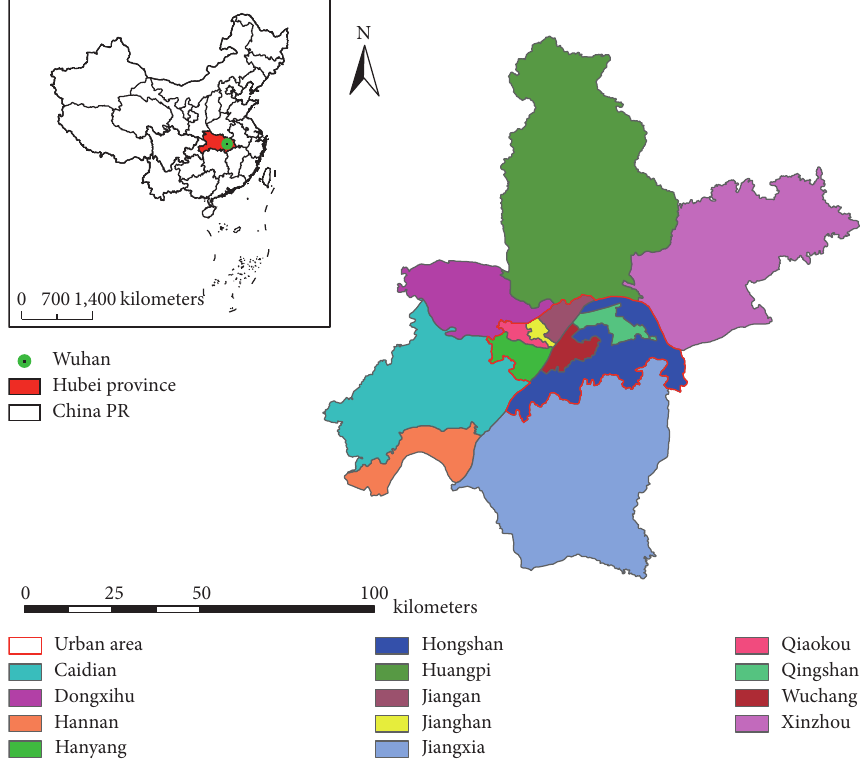
Figure 1: Location and administrative divisions of Wuhan City.